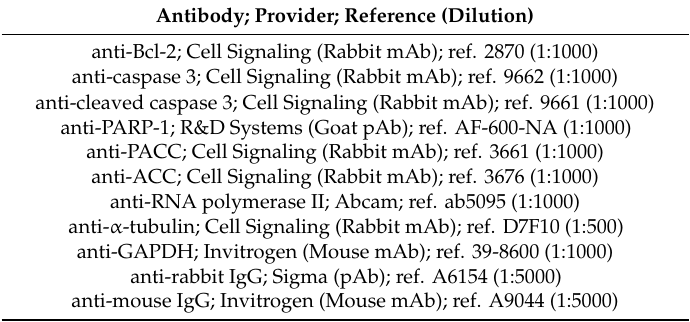
Table 1. Primary and secondary antibodies (supplier, reference, and dilution used).